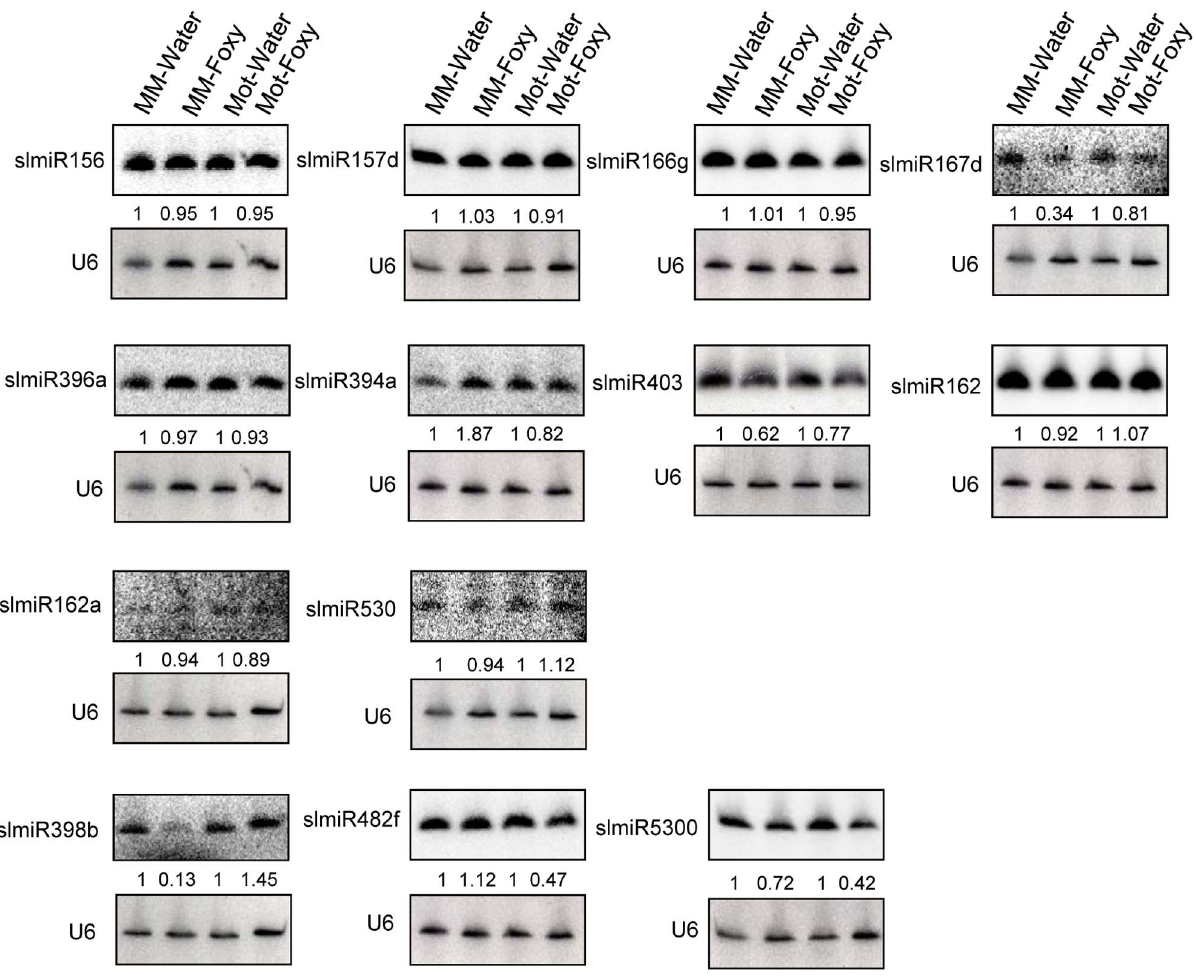
Figure 2. Northern blot analysis of miRNAs. Oligonucleotide probes were used to quantitate levels of several miRNAs identified during deep sequencing using northern blot analysis. Root total RNA samples (40 m g each) were from Moneymaker treated with water (MM-H 2 O), Moneymaker infected with F. oxysporum (MM-Foxy), Motelle treated with water (Mot-H 2 O) and Motelle infected with F. oxysporum (Mot-Foxy). U6 RNA served as a loading control for each blot. Blots were imaged using a Phosphorimager and miRNA species quantitated using Imagequant software, with normalization to the amount of U6 RNA. The numbers below each blot indicate the amount of miRNA in each sample relative to the corresponding water-treated control. Note that due to significant sequence homology, slmiR482 subfamily members cannot be quantitatively distinguished from one another using northern analysis.